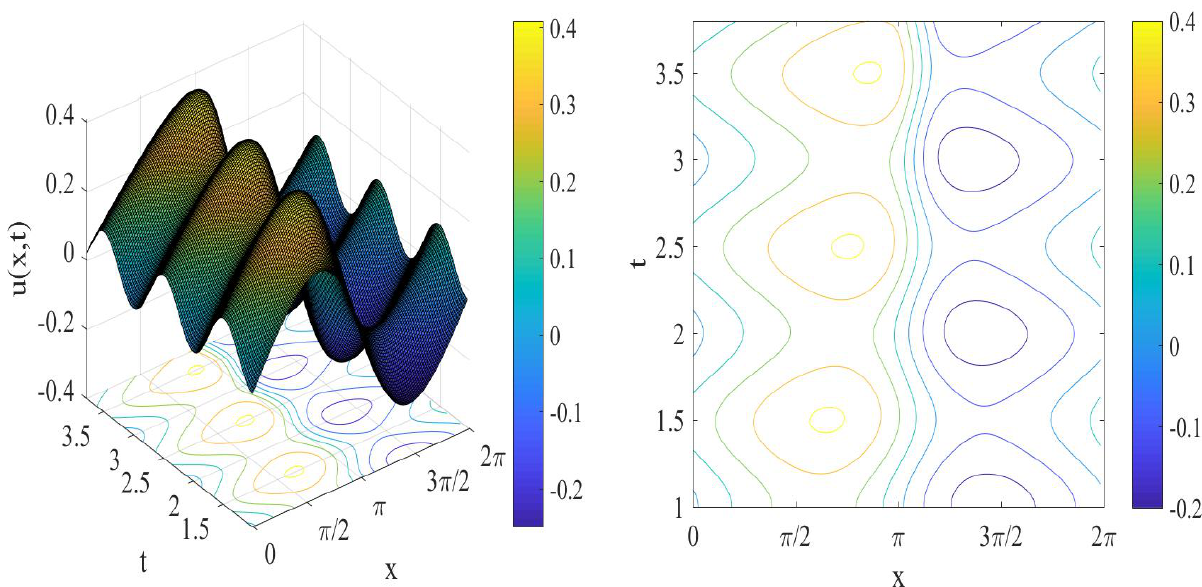
Figure 8. The mean of the solution ( left ) and its variance ( right ) for the inviscid Burgers’ equation at t f =4 , switching time t s =1 with modes N =4 . The reference solution is the PCM solution.